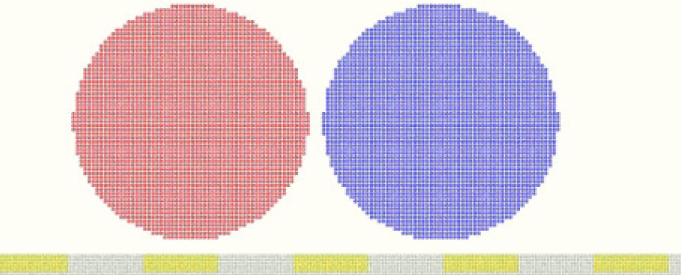
Figure 1. Initial configuration of coalescence of two argon droplets on a mixed-wettability superhy- drophobic surface (the yellow region is the more hydrophobic strip, while the gray region is the more hydrophilic